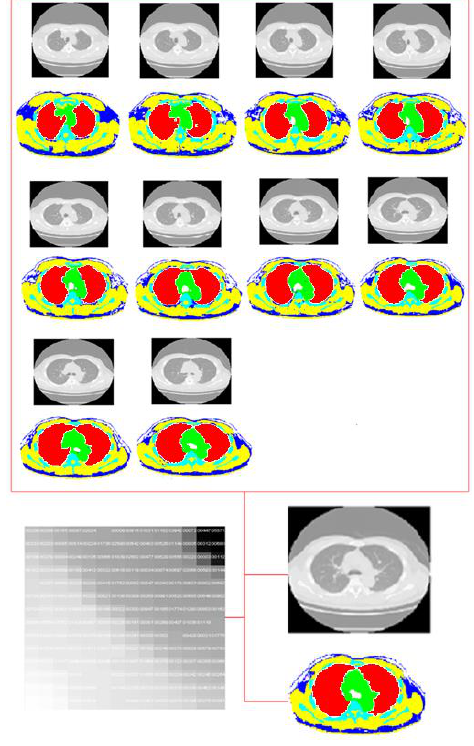
Figure 21. Chest and lung gray level slabs and their corresponding segmentations. A representative segmentation along with its 14 × 14 neural map.